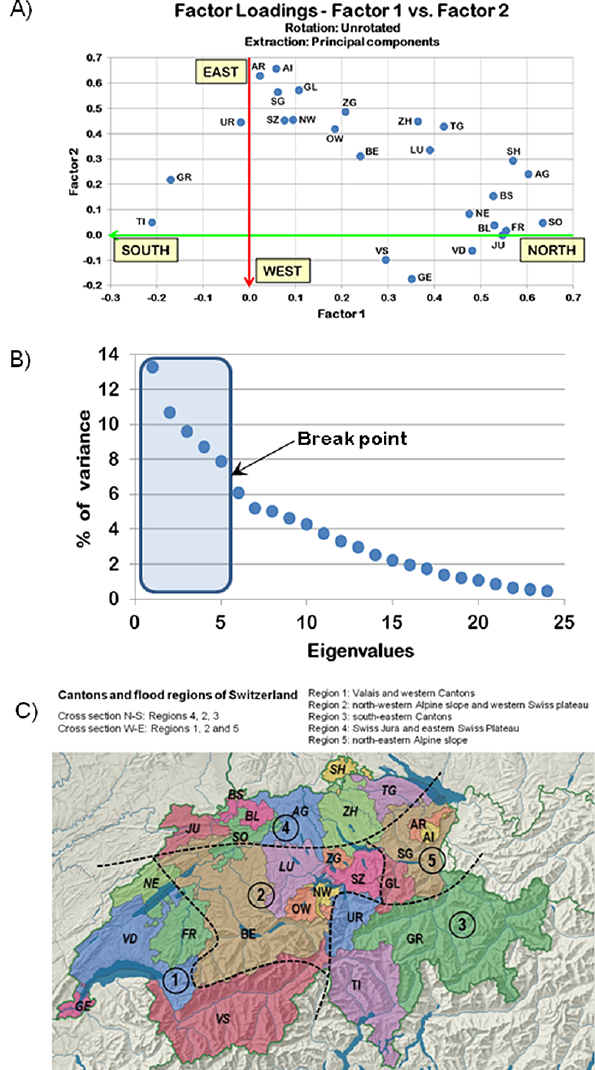
Figure 1. (a) Factor loadings of factor 1 versus factor 2 after the ap- plication of the PCA to the flood matrix without rotation. (b) Scree test and number of components selected. (c) Regionalization of Switzerland according to the PCA, applying the equamax rotation. The dotted lines show the limits of the regions (DEM from Atlas of Switzerland, 2004; map